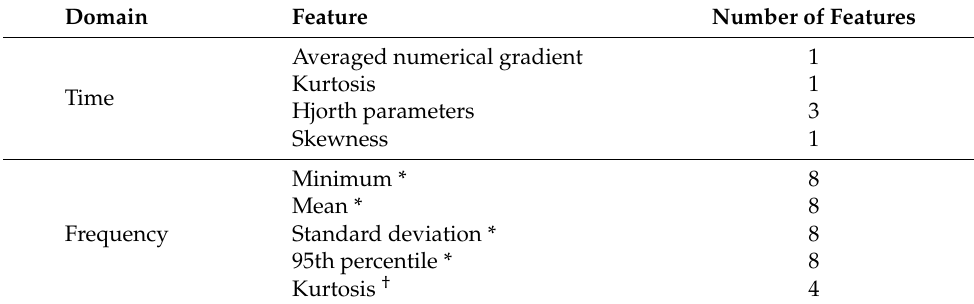
Table 2. Expert-defined features. Domain Feature Number of